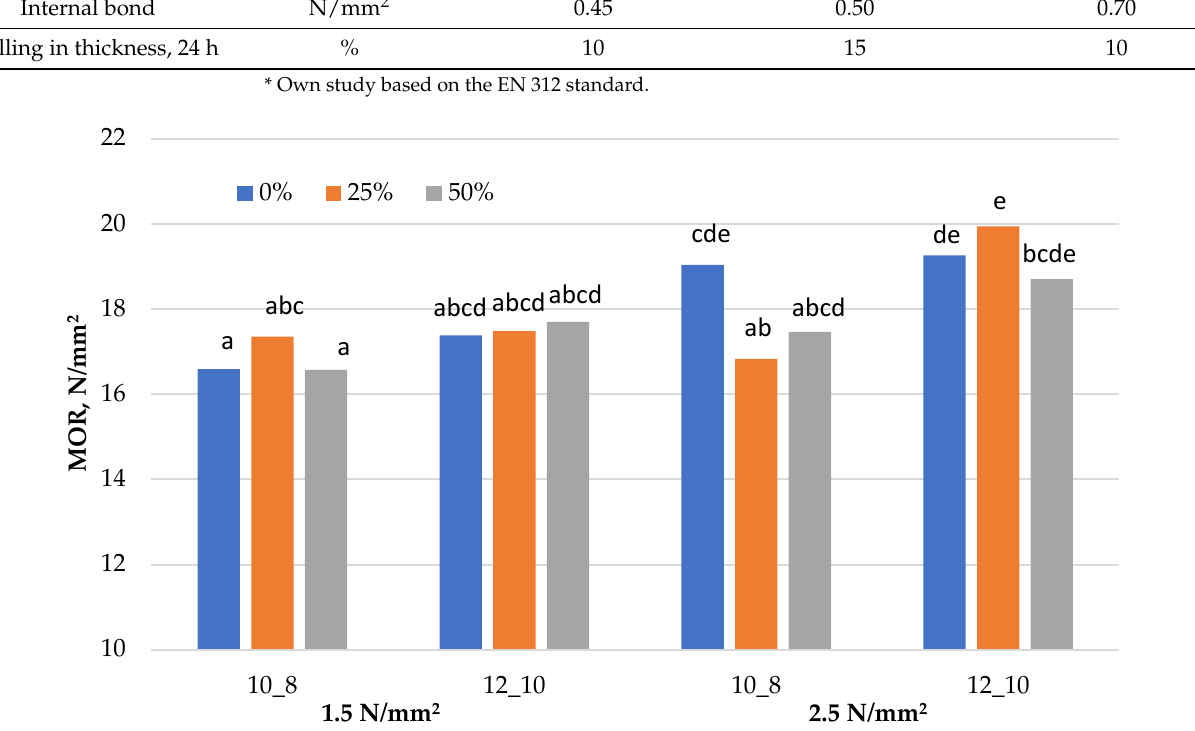
Figure 1. Bending strength (MOR) of particleboards produced.